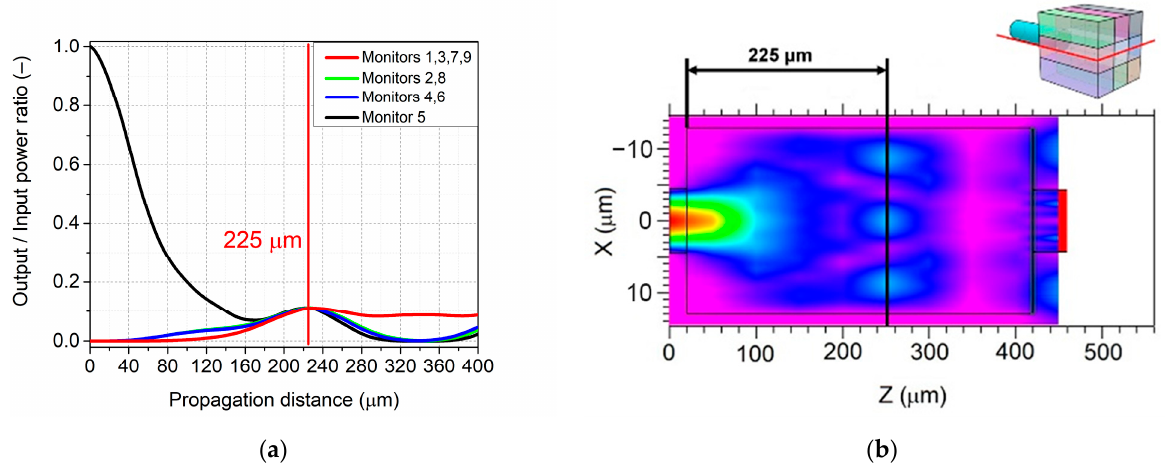
Figure 4. Power distribution throughout the 1 × 9 MMI: ( a ) Values of power for each monitor against propagation distance with optimal L π denoted by the red line, ( b ) Cross section of the power distribution at the central axis of the central three outputs.